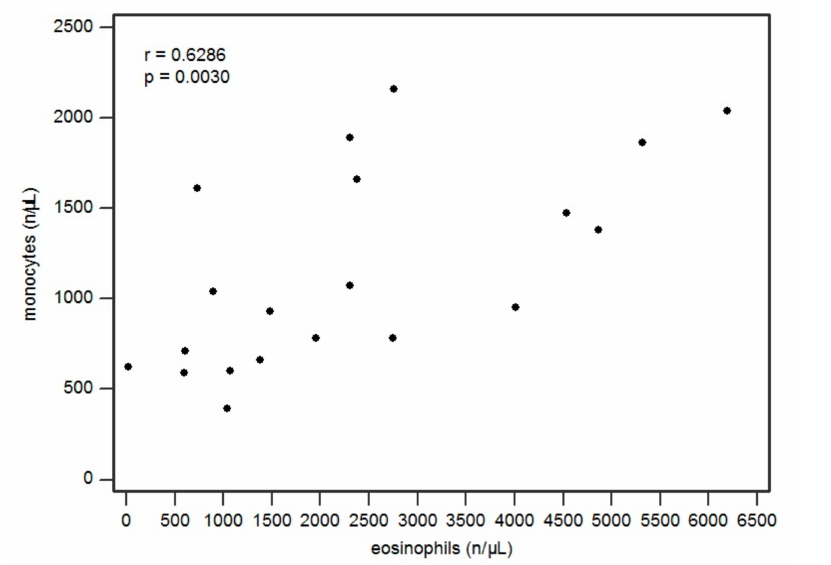
Figure 1. Scatterplot regarding correlation between eosinophil and monocyte values (in cells/ µ L). We detected an increase in C-reactive protein (CRP) in 19 out of 25 cases (76%) and an increase in erythrocyte sedimentation rate (ESR) in 5 out of 7 available cases; hyperfer- ritinemia was highlighted in 7 of the 8 cases evaluated.